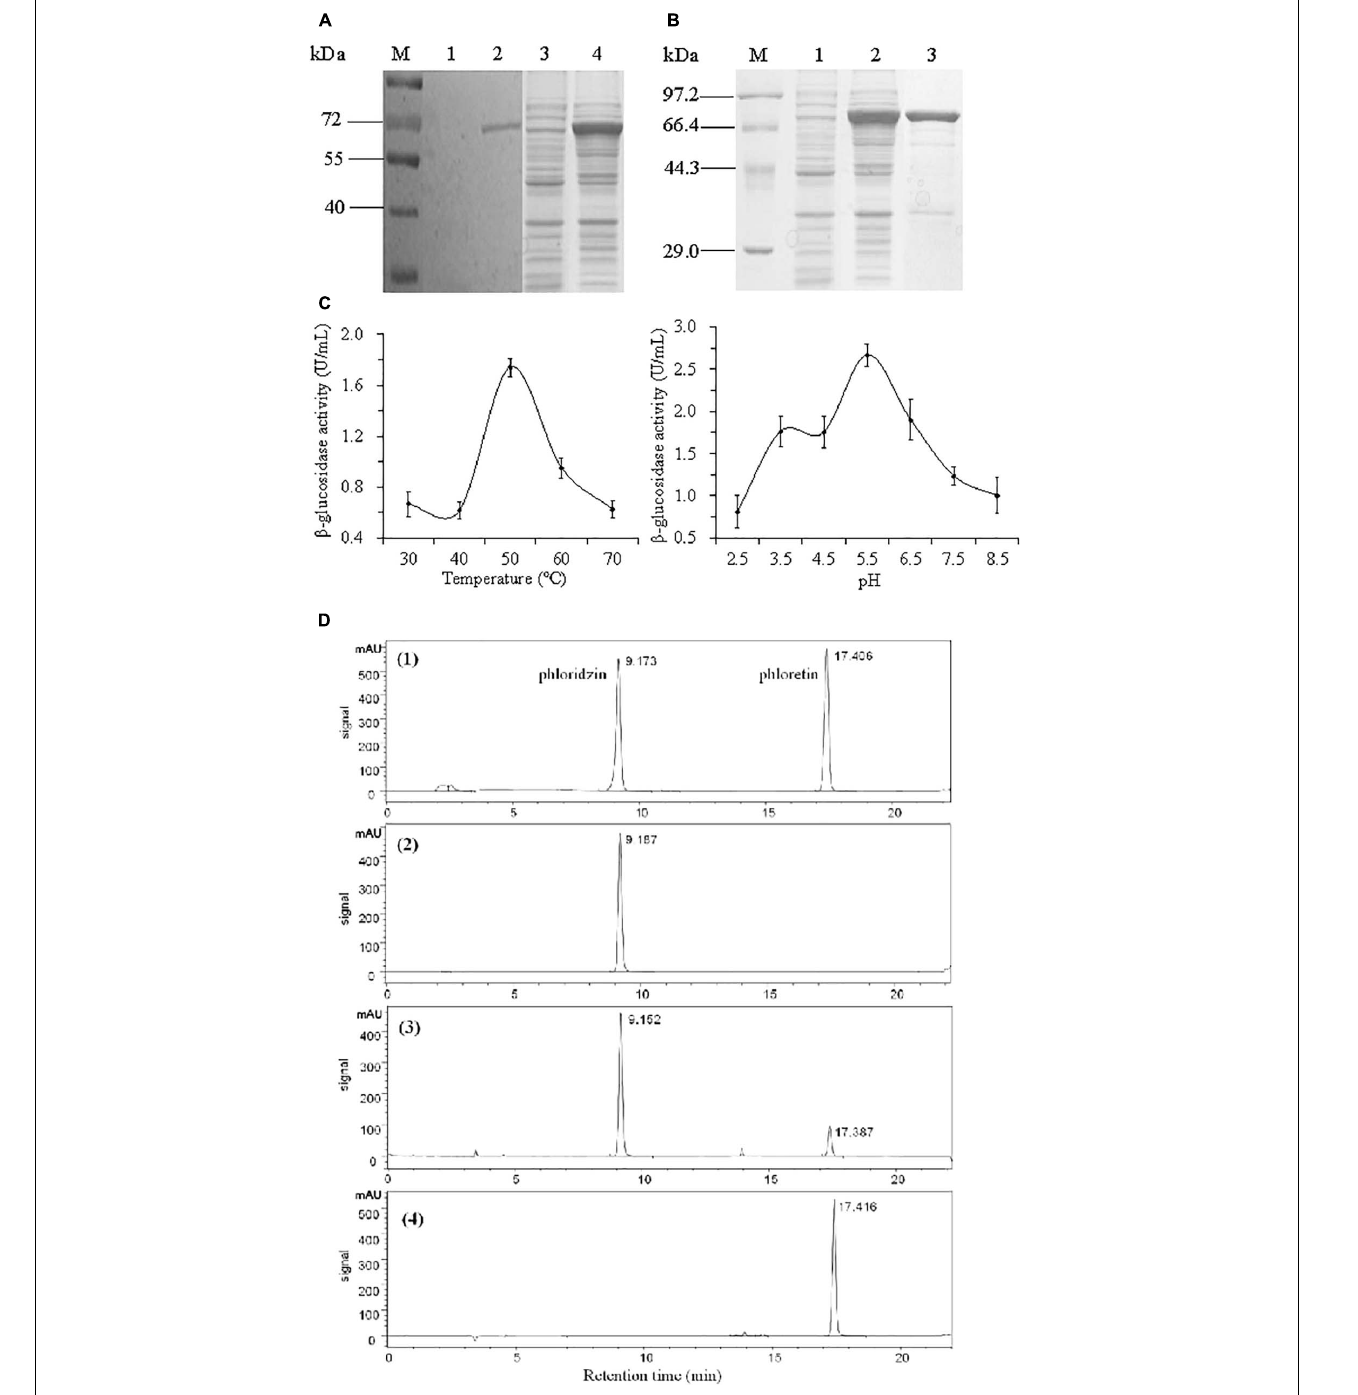
FIGURE 2 | The determination of VmGlu2 recombinant protein expression, purification and enzyme activities. (A) Detection of the expression of VmHbh2 recombinant protein by Western blot. Lane M, protein molecular weight marker (Low); Lane 1 and 3, the empty vector as control (about 20 µ g of total protein); Lane 2 and 4, the supernatant of the induced cells at 15 ◦ (about 30 µ g of total protein). (B) Detection of the purified VmHbh2 recombinant protein by SDS-PAGE. Lane M, protein molecular weight marker (High); Lane1, the empty vector as control; Lane 2, the supernatant of the induced cells at 15 ◦ , Lane 3, the purified recombinant protein. (C) Enzymatic activity of VmGlu2 recombinant protein when using pNPG as a substrate. (D) Enzymatic activity of VmGlu2 recombinant protein when using phloridzin as a substrate, and the data show the conversion of phloridzin into phloretin as determined by HPLC. (1), the standard of phloridzin and phloretin; (2), VmGlu2 recombinant protein and phloridzin (1 mg/mL) incubation for 0 h; (3), VmGlu2 recombinant protein and phloridzin (0.91 mg/mL) incubation for 24 h; (4), VmGlu2 recombinant protein and phloridzin (not detected) incubation for 72 h. The data next to the peak are the retention times for each compound.